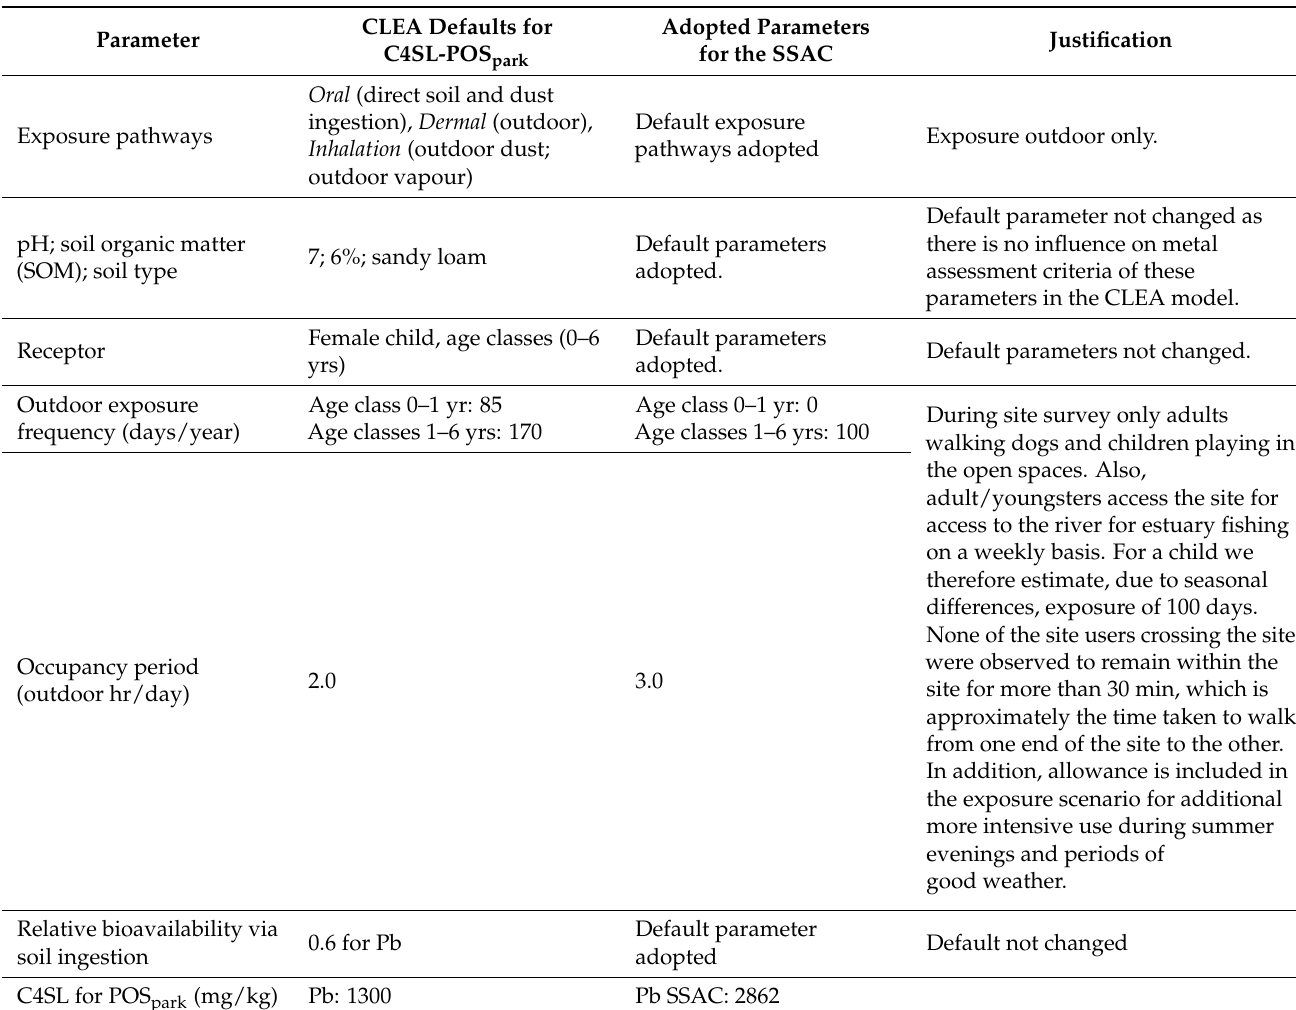
Table 2. CLEA parameter values used for calculating the SSAC, Pb (C4SL